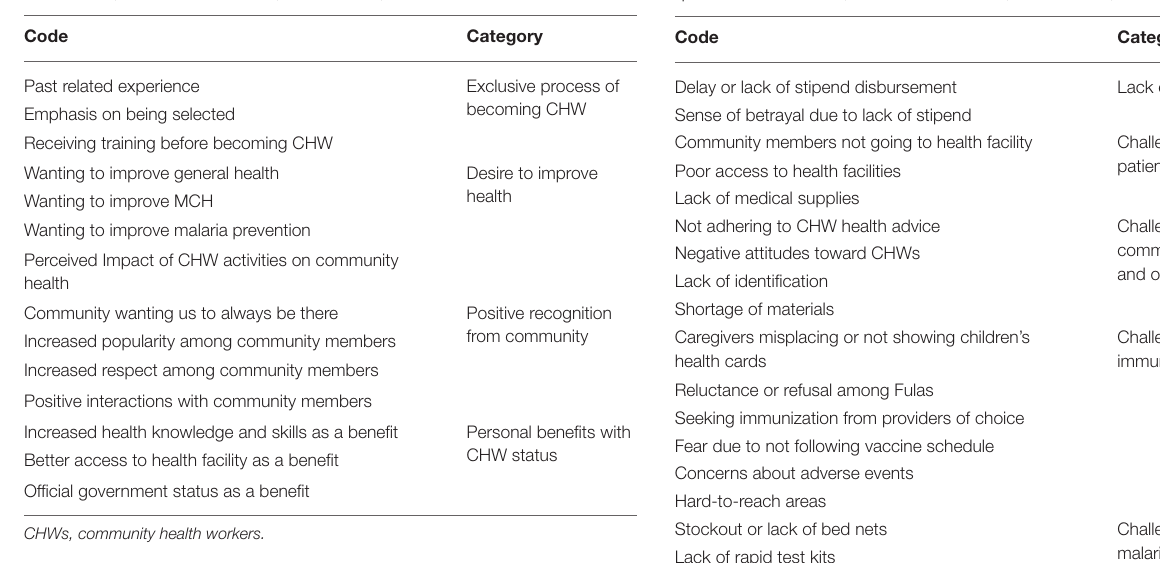
TABLE 2.3 | Codes and categories for Theme 3: “Health system and community-level barriers negatively affect CHWs’ activities and motivation”, qualitative assessment, Western Area Urban, Sierra Leone, 2018.